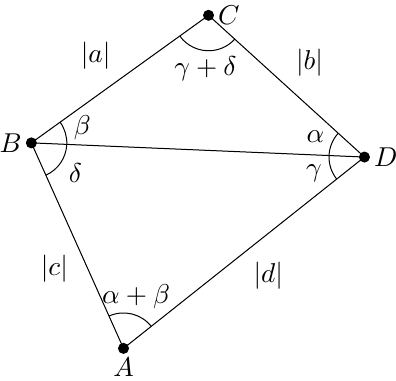
Figure 5 . Conifold quiver diagram.